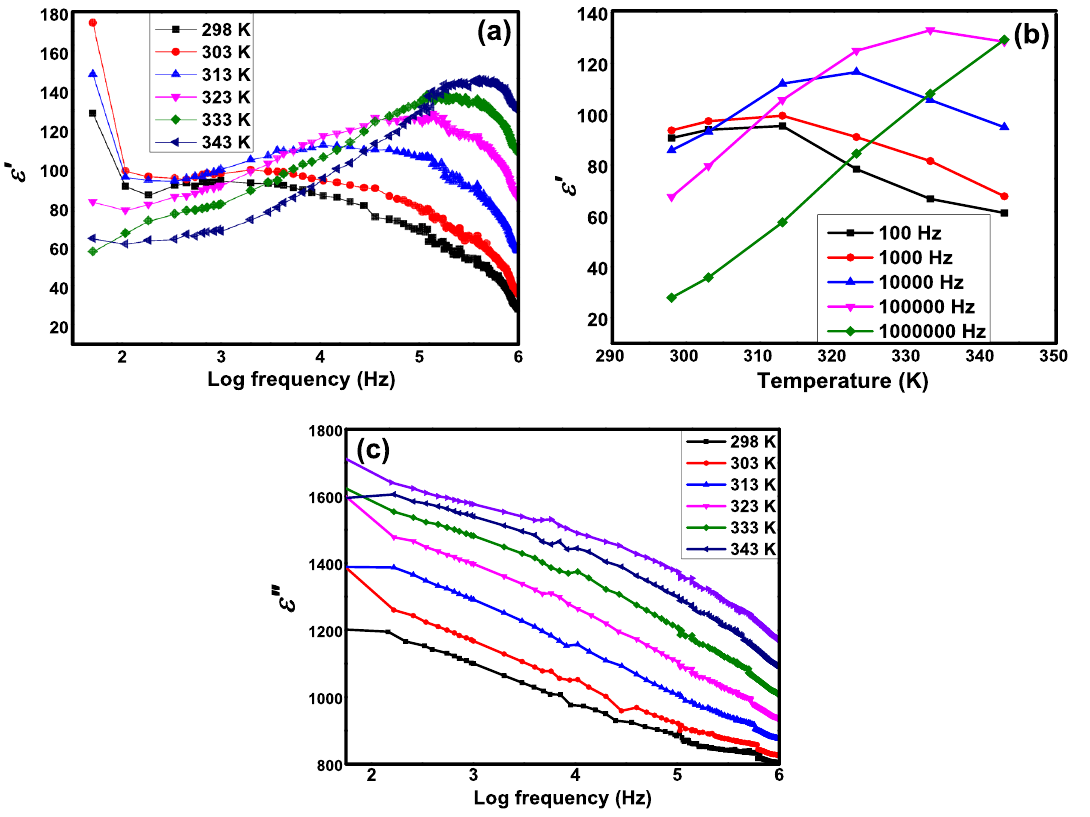
Figure 7. ( a ) Variation of ε ′ in SrLaLiTe 1− x Mn x O 6 ( x = 0.08) with respect to temperatures, ( b ) variation of ε ′ in SrLaLiTe 1− x Mn x O 6 ( x = 0.08) with respect to frequencies, and ( c ) variation of ε ′′ in SrLaLiTe 1− x Mn x O 6 ( x = 0.08) with respect to